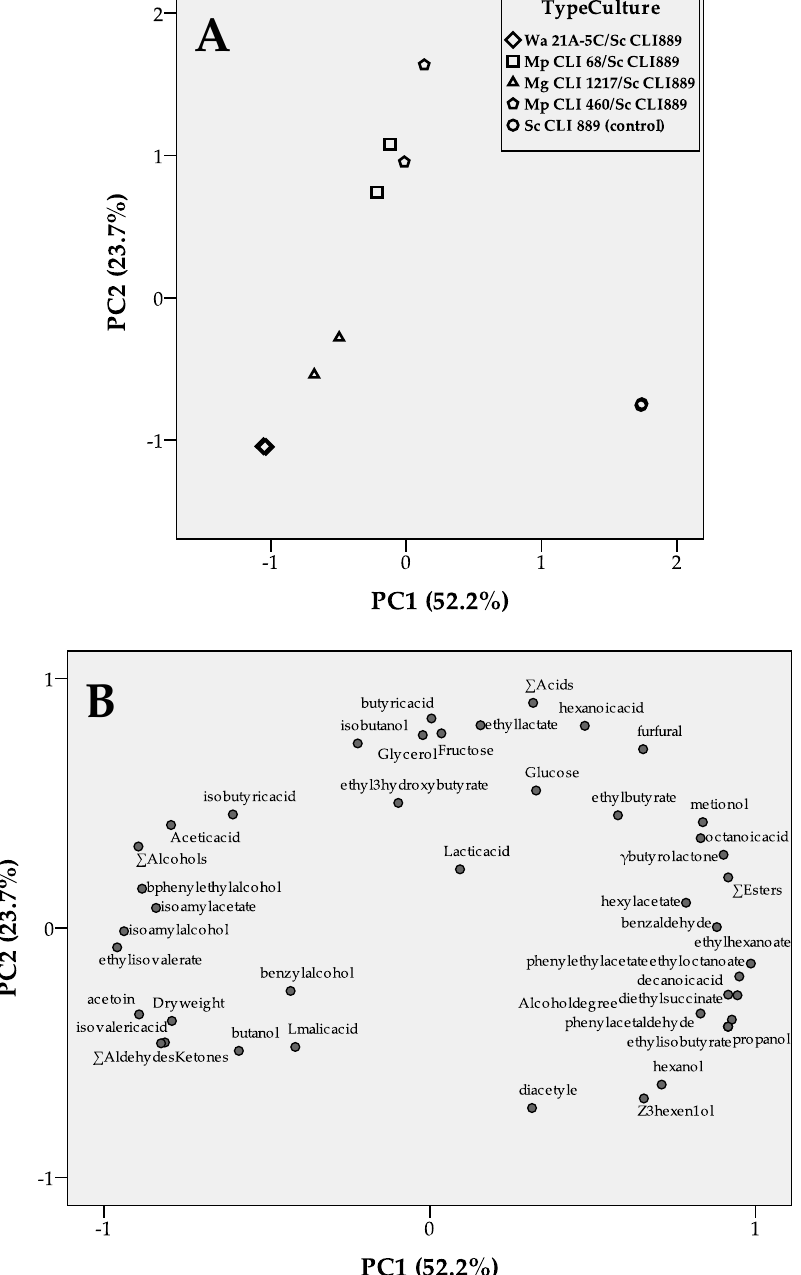
Figure 2. Principal component analysis (PCA) score plot ( A ) and loadings plot ( B ) using main fermentation parameters and 32 volatile compounds.